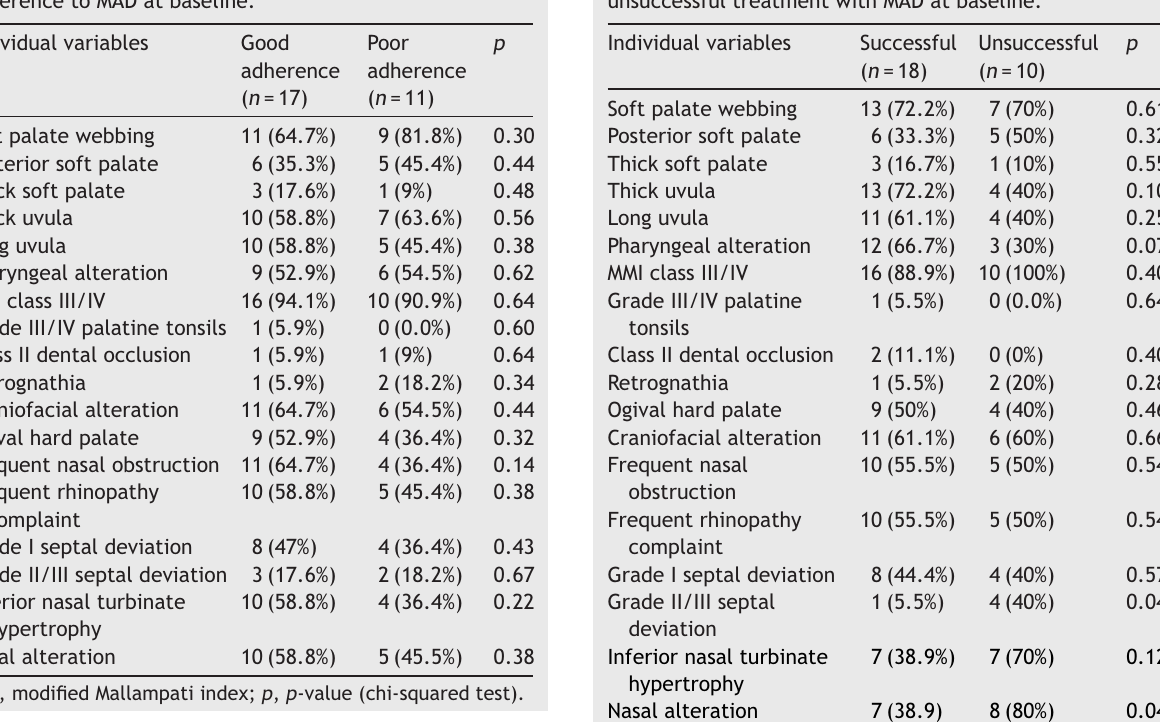
Comparison of upper airway assessment and cra- niofacial parameters between patients with good and poor adherence to MAD at baseline.